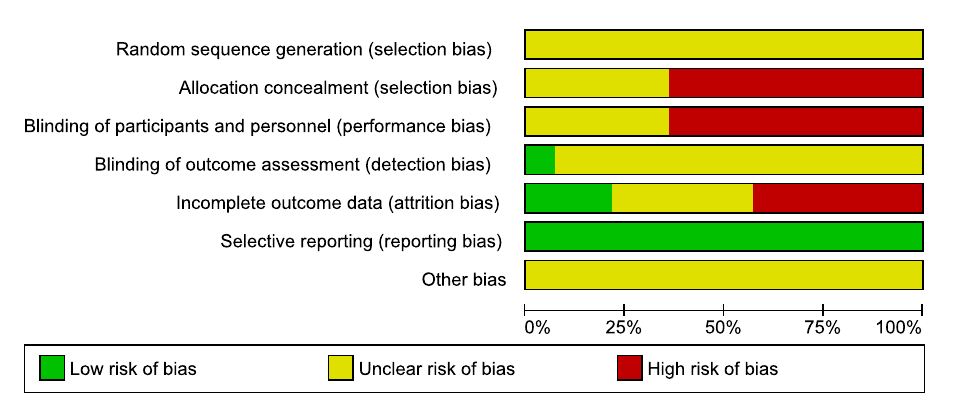
Table 1. Summary of the main characteristics of the included studies. F female, M male, U unclear, IP intraperitoneal, DOX doxorubicin, AET aerobic training, TM treadmill, WR wheel running, FS fractional shortening, ECO echocardiography.